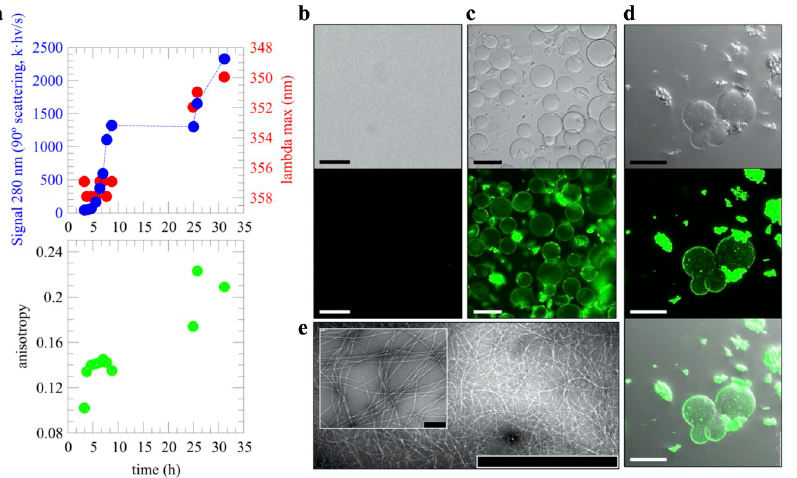
Fig 2. Droplet assembly is coupled to fibril formation. (a) Light scattering following the signal at 280 nm over time (top, blue circles), maximum emission wavelength (top, red circles), and fluorescence anisotropy (bottom, green circles) over time during droplet and fibril formation. (b) The TDP-43’s PrLD sample eluted from the column is free of droplets (top). To test for the presence of amyloid fibrils, ThT was added to the sample and visualized by fluorescence microscopy (bottom). The lack of fluorescence indicates that no amyloid fibrils are present at the beginning of the experiments. (c) Aggregated samples (i.e., samples where no signal is detected in LSNMR experiments) present extensive droplet formation, as well as irregularly shaped clumps (top, light transmitted image). Interestingly, both the droplets and the clumps were recognized by ThT (bottom, fluorescent image). These images were collected using fluorescence microscopy on 110 μ M TDP-43 PrLD. The scale bars in panels a and b are 100 μ m. (d) Confocal microscopy images of the 55 μ M aggregated sample (transmitted light, top; fluorescence, middle; overlay, bottom) showing ThT bound to droplets surface as well as to the irregularly shaped clamps, suggesting that the latter are made by amyloid fibrils which are formed and released from the droplet surface. Scale bar is 50 μ m. (e) TEM micrographs confirmed the presence of amyloid fibrils, in agreement with ThT fluorescence (scale bar: 2 μ m; at inset image: 200 nm). Numerical data for panel A can be found in S1 Data. PrLD, prion-like domain; TDP-43, Transactive response DNA-binding Protein of 43 kDa; TEM, transmission electron microscopy; ThT, Thioflavin T.